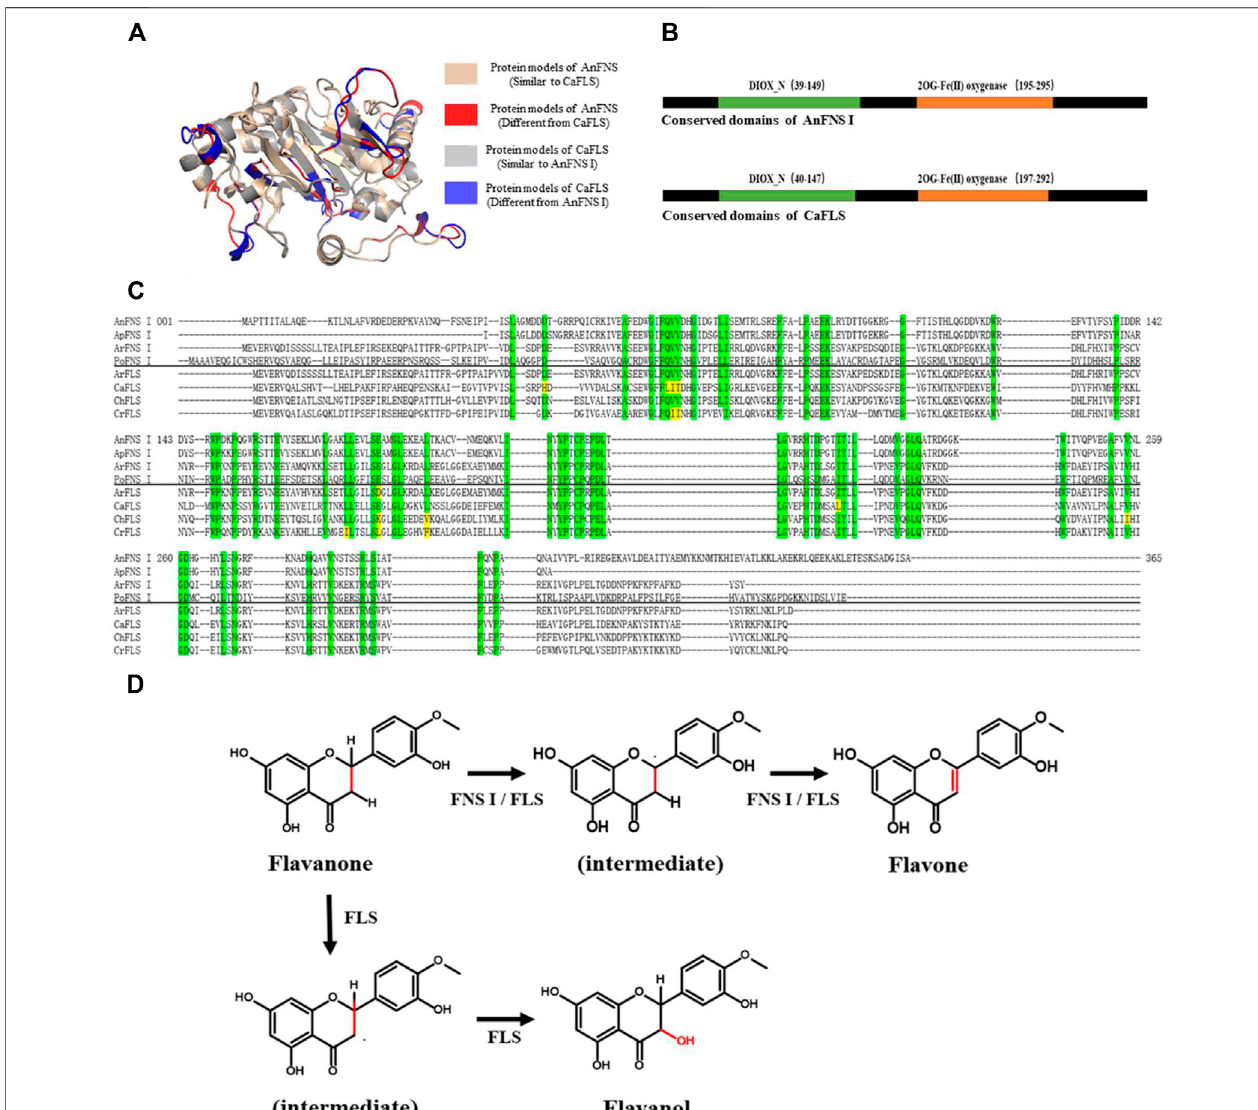
FIGURE 1 | Structure and Catalytic Process of FNS/FLS. Note: (A) Structural differences between AnFNS I and CaFLS (The portions of the protein models with signi fi cant structural differences are displayed in different colors. Brown and red show the structure of wild-type CaFLS. Gray and blue show the structure of wild-type AnFNS I. Also red and blue indicates the portion of the wild-type CaFLS that differed signi fi cantly from AnFNS Ⅰ ) (B) The conserved domain difference between AnFNS I and CaFLS. (C) The conserved amino acid differences between multiple CaFLS and FNS ( AnFNS I Flavone synthase I of Angelica archangelica ; ApFNS I Flavone synthaseIof Apium graveolens ; PoFNS IFlavonesynthaseIof Pohlianutans ; ArFNS IFlavone synthase Iof Arabidopsislyrata ; ArFLS FlavonolSynthaseof Arabidopsis thaliana; CaFLS Flavonol Synthase of Camellia sinensis; ChFLS Flavonol Synthase of Chrysanthemum x morifolium ; CrFlS Flavonol Synthase of Crocosmia x crocosmii fl ora. Green is annotated with conserved amino acids, yellow with non conserved amino acids) (D) Reaction process of synthesis of Flavone from Flavanone catalyzed by FNS/FLS.